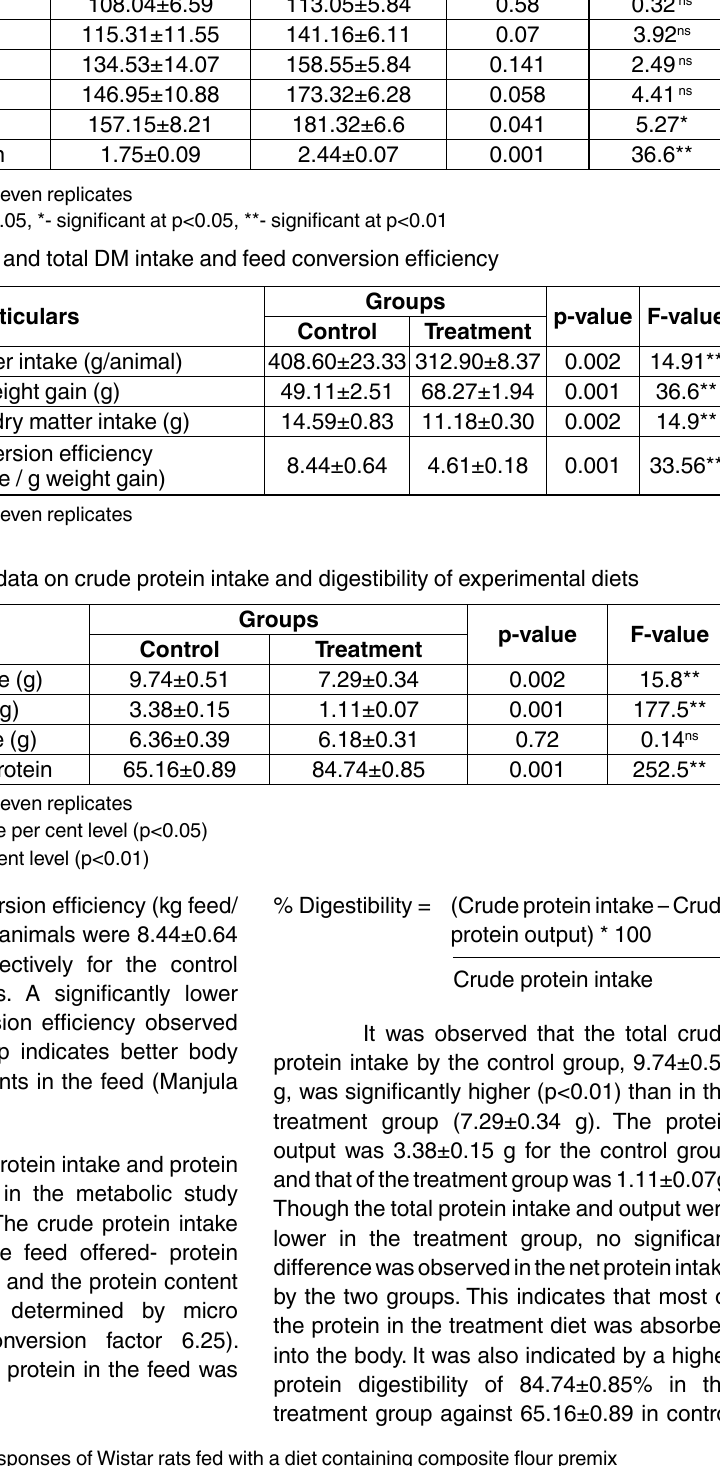
table 4. Weekly average body weight and average daily weight gain in Wistar rats